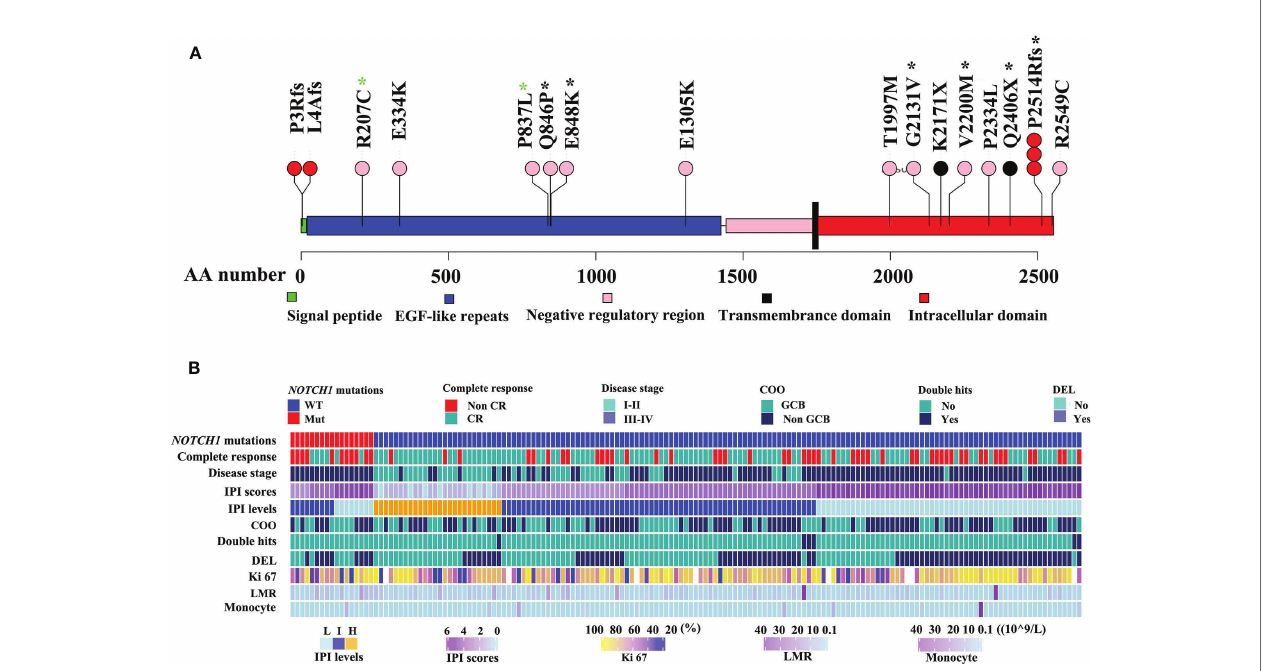
FIGURE 1 | Mutation maps of the NOTCH1 protein (A) . The x-axis reports the amino acid(AA) number. The circles are colored with respect to the corresponding mutation types: “ black ” representing Non-sense mutations, “ red ” equaling to frameshift mutations, “ pink ” representing missense mutations. Black stars representing mutations identi fi ed by Sanger sequencing, while green stars representing no mutations identi fi ed by Sanger sequencing. The detailed clinical information of DLBCL was illustrated (B) . IPI, International Prognostic Index; non-GCB, non-germinal center B-cell-like lymphoma; DEL, double expressor lymphoma; HB, hemoglobin; LMR, lymphoma-to-monocyte